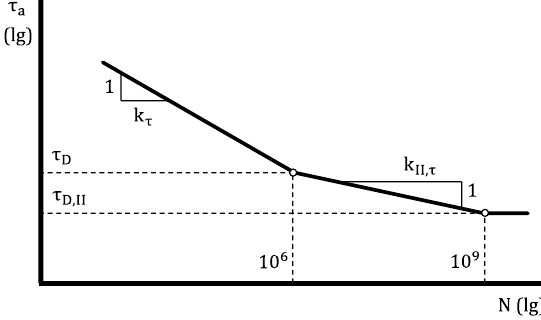
Figure 2. Model of the fatigue curve employed in the upcoming Forschungskuratorium Maschinenbau (FKM) guideline for springs and spring elements with stress amplitude τ a , number of cycles N stress amplitudes at kink points τ D and τ D,II as well as slopes k τ and k II, τ , modified from